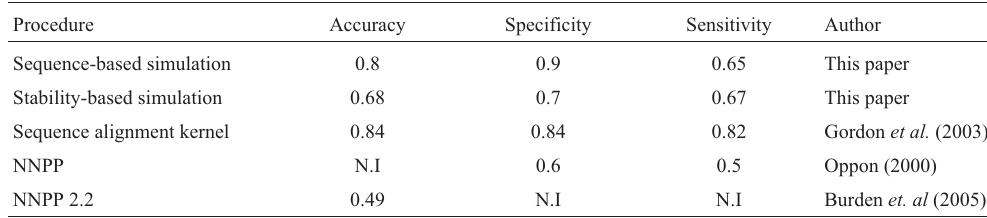
The numbers in bold indicate the highest scores for each parameter. N.I. = no